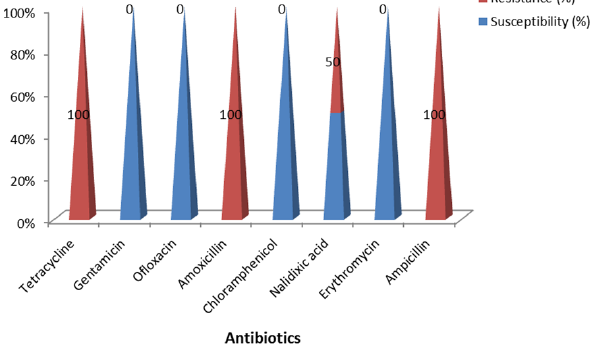
Fig. 8. Percentage Multiple Antibiotics